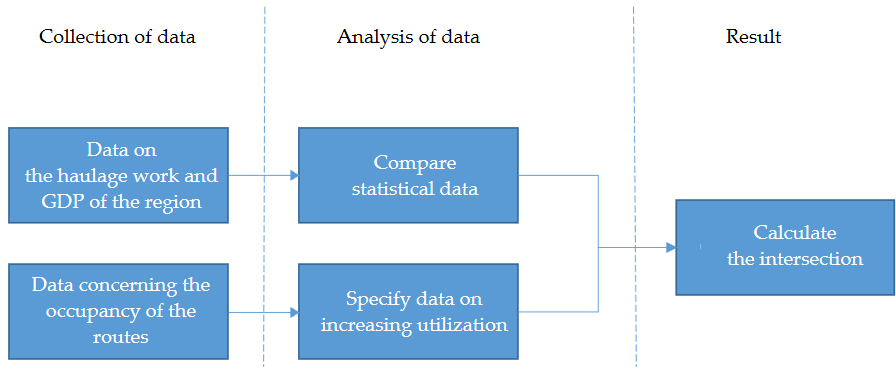
Figure 3. Plan for the preparation of data for the calculation of railway transport potential.